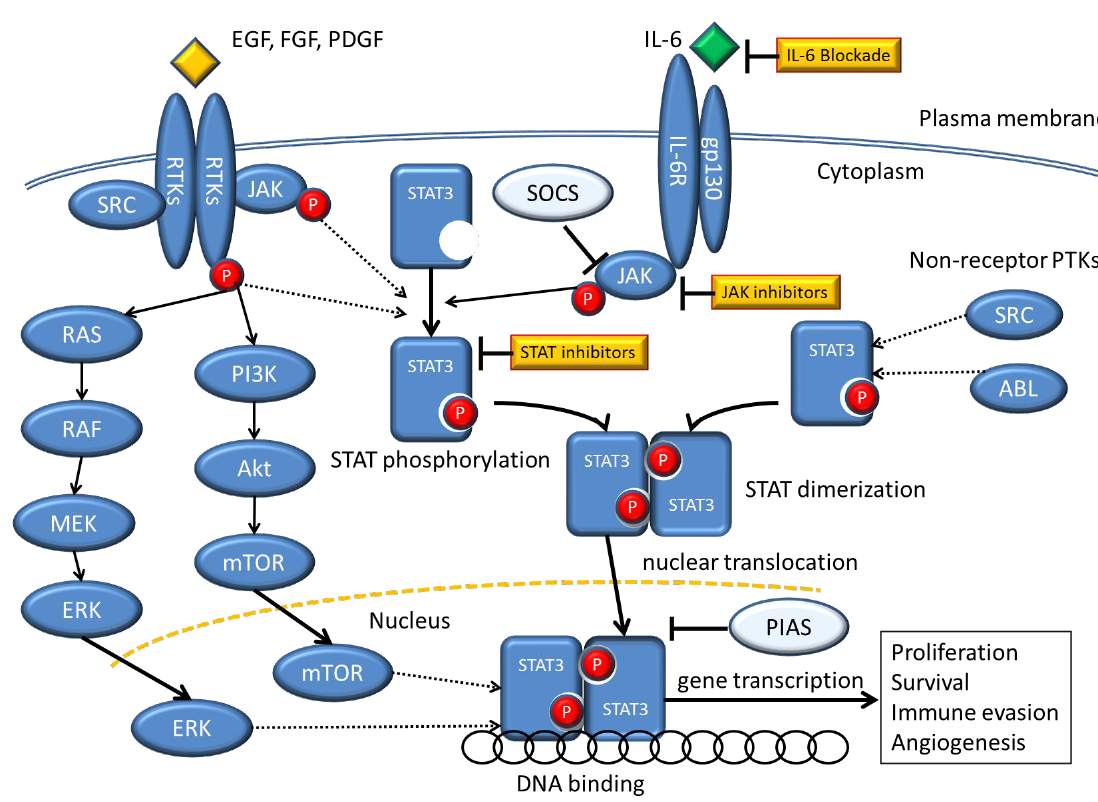
Figure 1. Signaling pathways that converge on